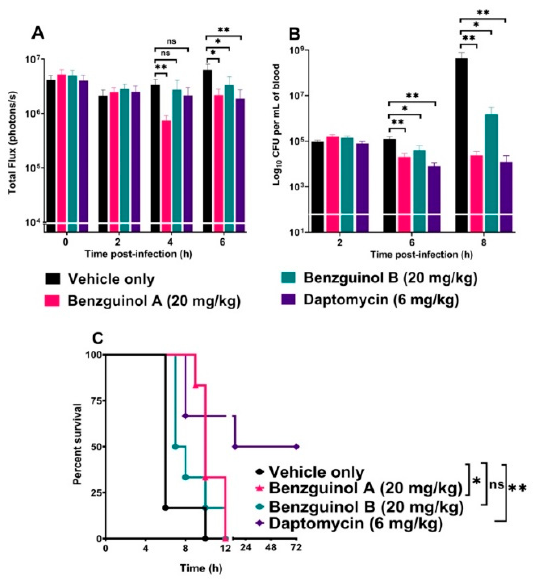
Figure 7. Benzguinol efficacy data. ( A ) Comparison of luminescence signals and ( B ) bacterial load in blood between groups of CD1 mice ( n = 6) challenged IP with bioluminescent S. aureus ATCC 12600 (Xen29) and treated with the indicated drugs. Mice were subjected to bioluminescence imaging on IVIS Lumina XRMS Series III system at the indicated times. ns, not significant; *, p < 0.05; **, p < 0.01; Mann–Whitney U -test (one-tailed). ( C ) Survival analysis for mice treated with the indicated drugs. ns, not significant; *, p < 0.05; **, p < 0.01; Log-rank (Mantel–Cox test).